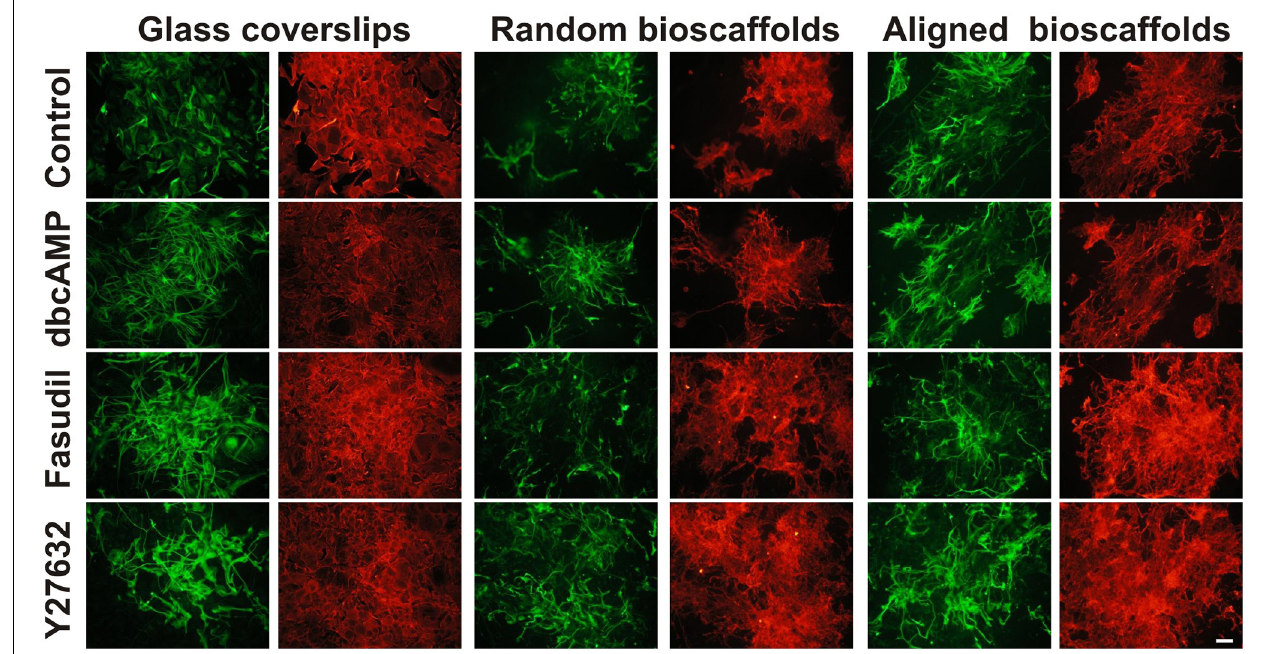
FIGURE 1 | Effect of drug treatments on morphology and expression of GFAP and AHNAK in astrocytes cultured on different substrates. Astrocytes were treated for 72h with vehicle (Control), dbcAMP (1mM),